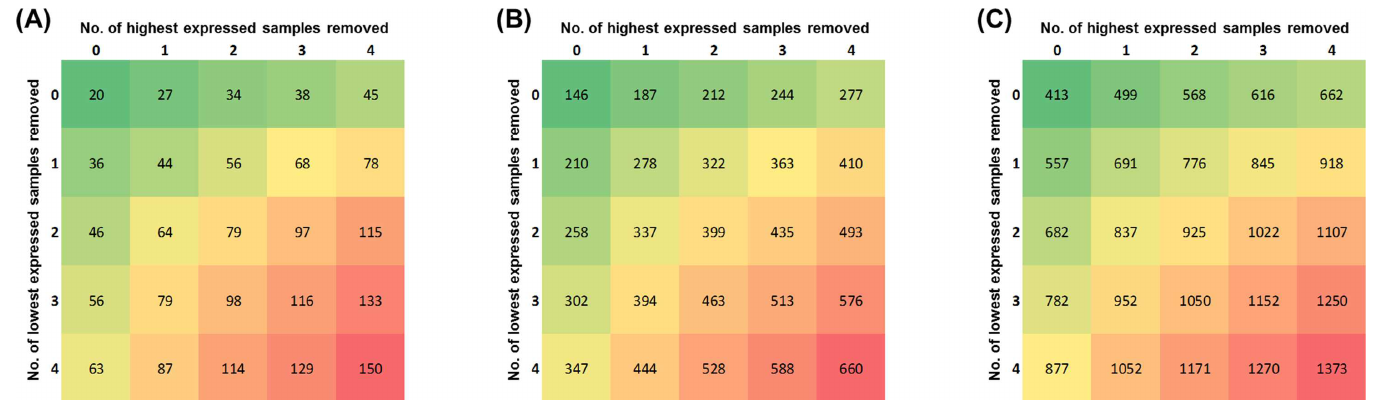
Fig 2. Numbers of stably expressedgenes at different thresholds of expressionfold-change and numbers of highest and lowest expressed samples removed. (A) Cutoff criteria of expressionchangesof (cid:20) 3-fold. (B) Cutoff criteria of expressionchangesof (cid:20) 4-fold. (C) Cutoff criteria of expression changesof (cid:20)